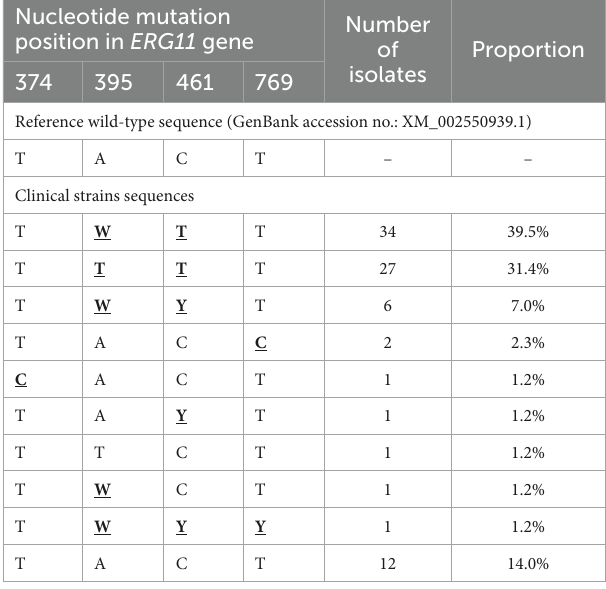
Nucleotide mutation position in ERG11 gene